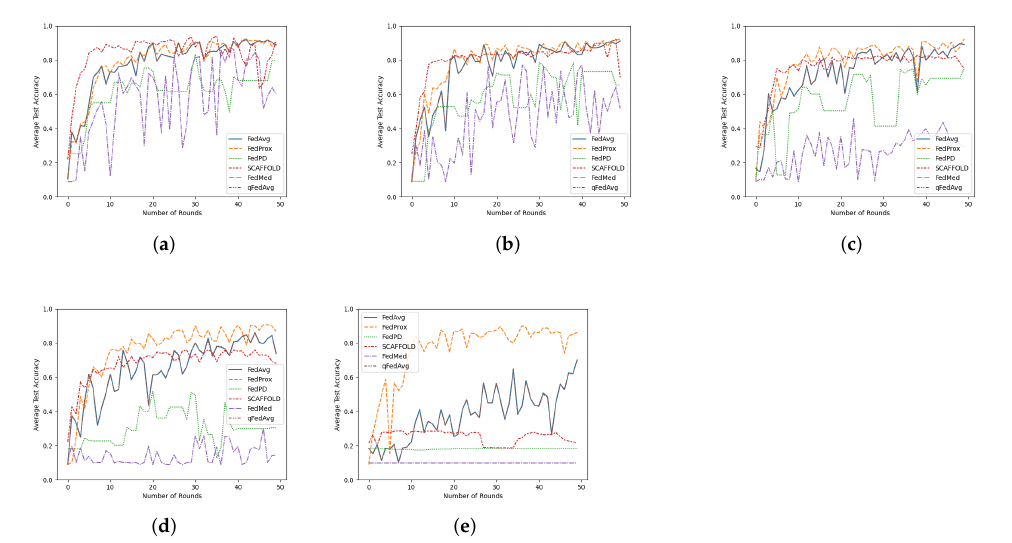
Figure 4. Average accuracy for ( a ) 10%, ( b ) 30%, ( c ) 50%, ( d ) 70%, and ( e ) 90% stragglers over non-IID data for MNIST data set.